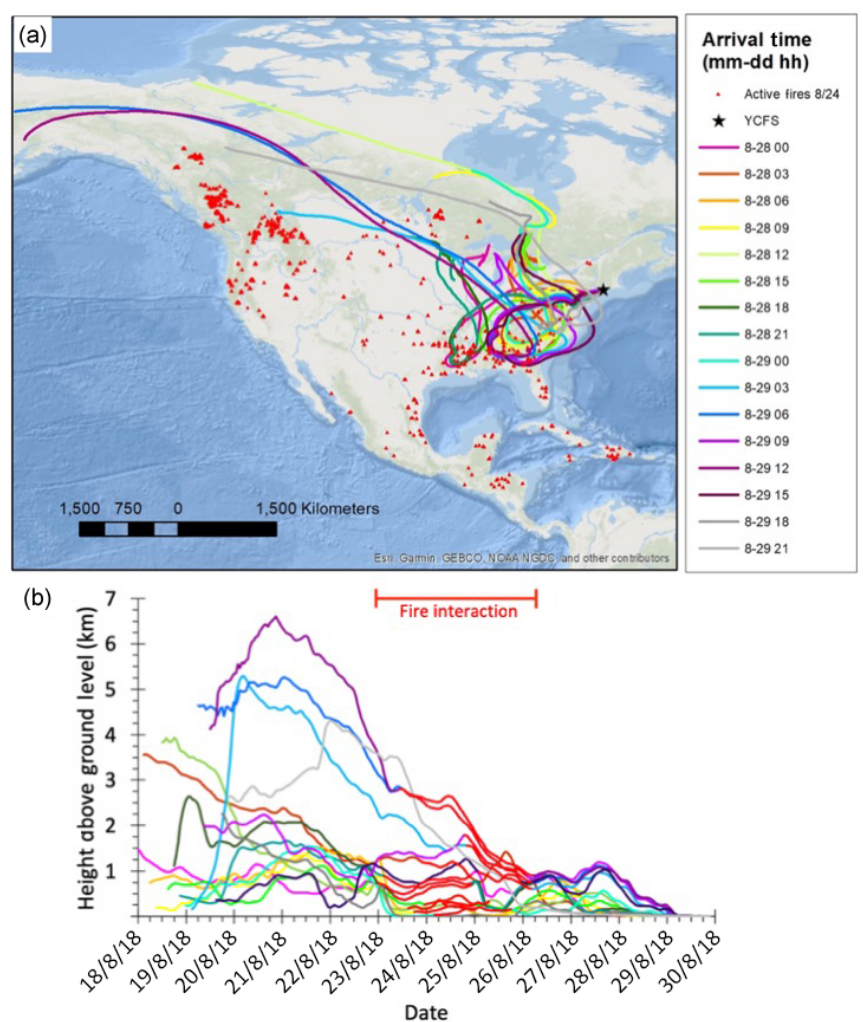
Figure 6. NOAA HYSPLIT back-trajectory model results for air parcels arriving on 28 and 29 August 2018 to surface-level YCFS site. Each color represents the backward trajectory for an air parcel arriving every 3h throughout the course of the day. The location of fires on 24 August (when most trajectories intersect the fire zone in the southeastern US) is depicted with red triangles (from NOAA HMS fire maps). The top map (a) shows the full 10d trajectory, and the bottom graph (b) shows the vertical height of each air parcel along its trajectory as well as the time where it may have intercepted fire smoke plumes (highlighted in red on each individual trace). The last two trajectories on 8–29 have no major fire interaction and have thus been colored